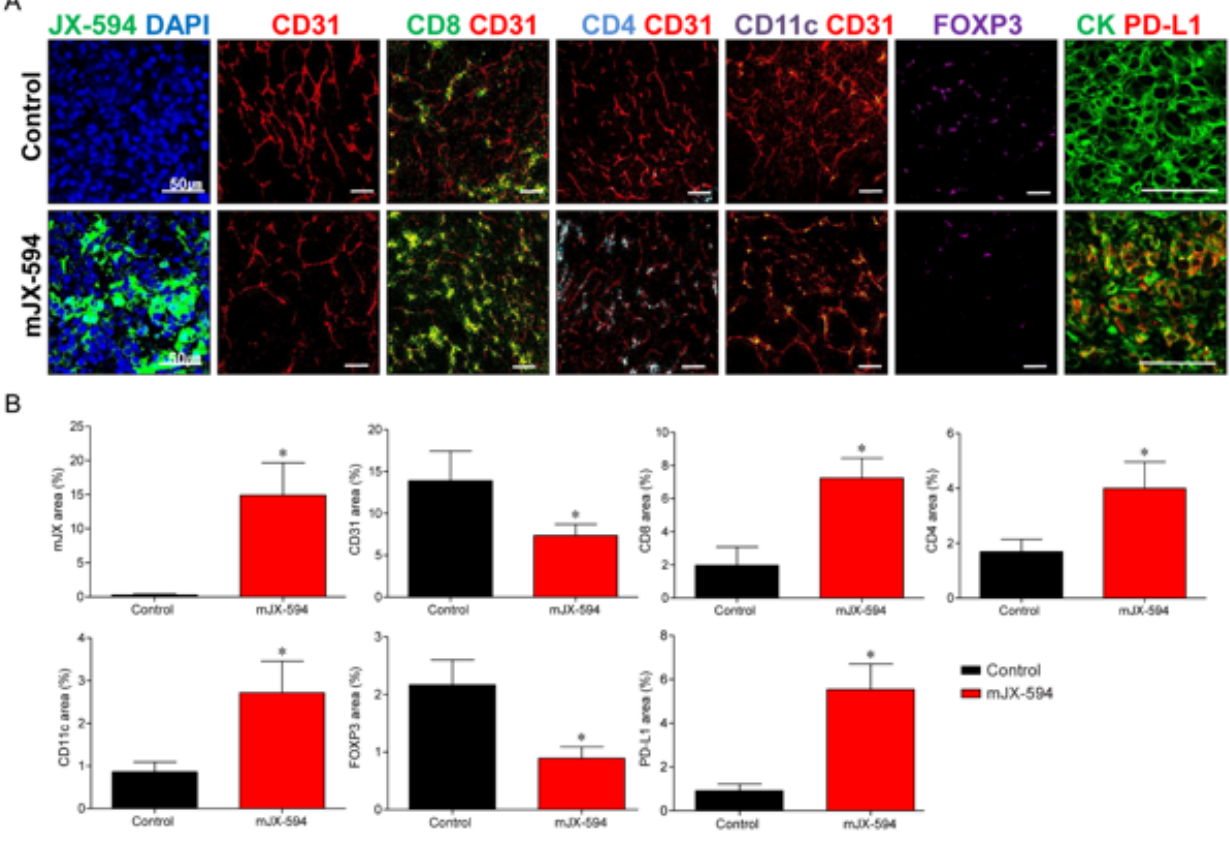
Figure 5. mJX-594 systemic treatment activates anti-cancer immunity by converting immunosuppressive noninflamed tumors into inflamed tumors at lung metastatic sites. ( A ) Representative images of lung metastatic sites treated with mJX-594 systemic treatment. Tumor sections were stained for JX-594, CD31, CD8, CD4, CD11c, Foxp3, and PD-L1. Scale bars, 50 μm. ( B ) Quantifications of the JX-594+ area, CD31+ blood vessels, CD8+ T cells, CD4+ T cells, CD11c+ dendritic cells, Foxp3+ regulatory T cells, and PD-L1+ cells. Values are mean ± SD. * p < 0.05 vs. control. 6 animals per group were used.